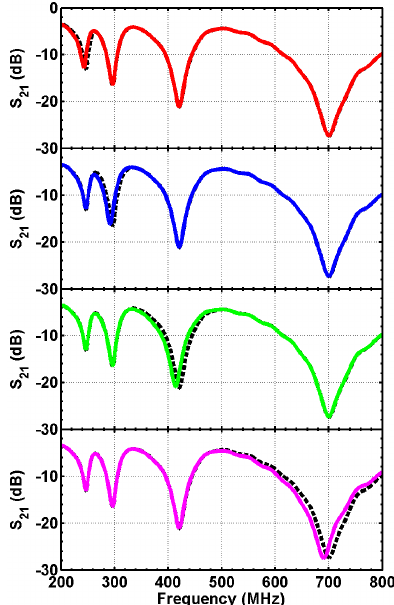
Figure 10. Measured transmission spectrum when the target is facing each of the four sensors. The dashed line is the measurement from the unloaded sensors.